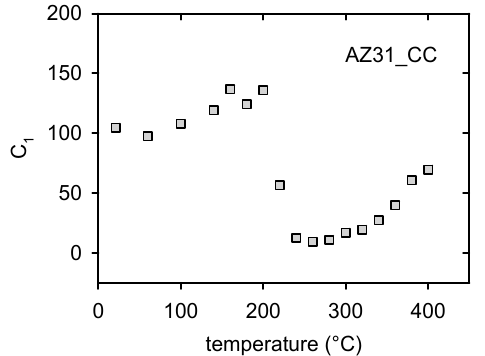
Figure 11. The fitting parameter C 1 depending on the upper temperature of the thermal cycle.